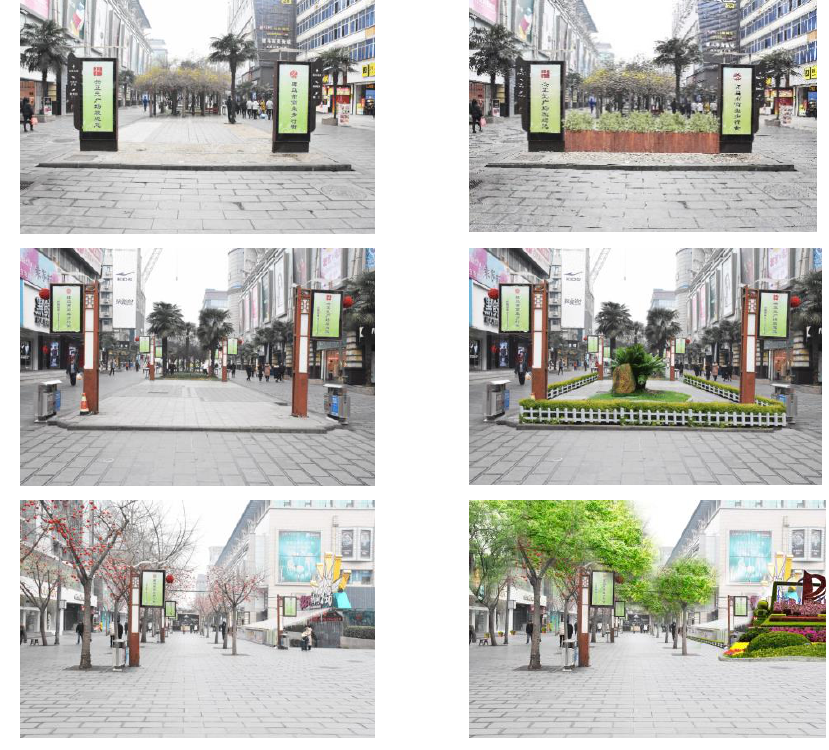
Figure 1. Visual stimuli.